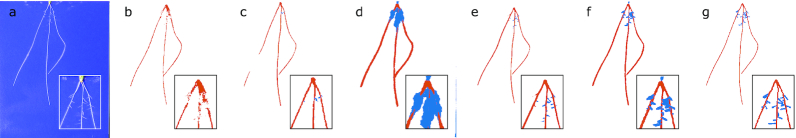
Example image output from each trained network architecture. (a) An example hydroponic wheat image. (b) VGG [38]. (c) FCN [39]. (d) SegNet [40]. (e) UNet [41]. (f) DeepLab-V3 [42]. (g) RootNav 2.0.